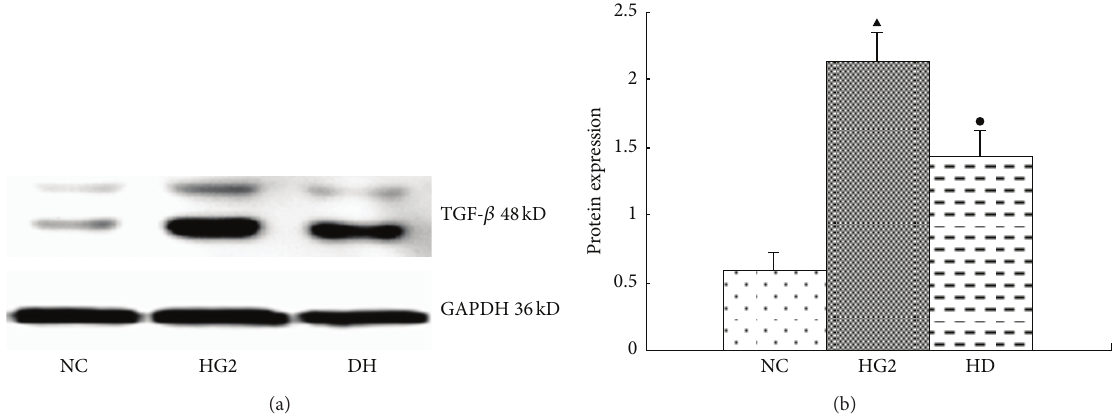
Figure 8: The expression of TGF- 𝛽 after intervention with DAPT determined using western blot for 24hr. (a) Western blot strip chart. (b) The gray graph shows the relative statistical values for TGF- 𝛽 in each group. Compared with the NC group, the expression of the TGF- 𝛽 protein was significantly increased in the HG2 group. After DAPT intervention, the protein expression of TGF- 𝛽 decreased. 󳵳 𝑃 < 0.05 versus NC group; ∙ 𝑃 < 0.05 versus HG2